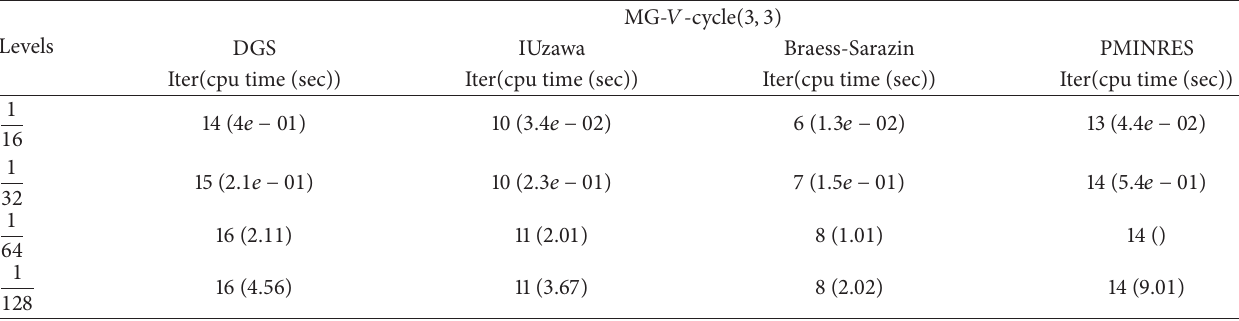
Table 6: Number of iterations and CPU time of iterations for multigrid ( 𝑉 -cycle) with different smoothers and using one V -cycle multigrid preconditioner approximation (for both